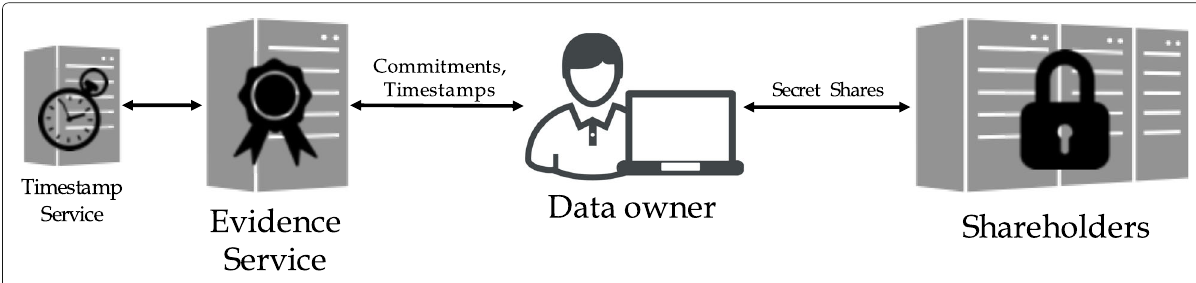
Fig. 1 Overview of the components of